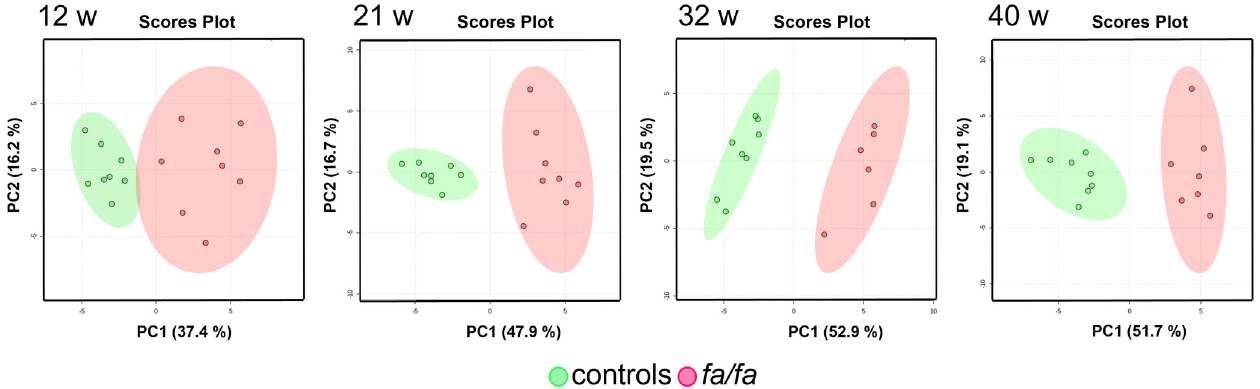
Figure 2. Score plots of PCA models of urine at 12, 21, 32, and 40 weeks. Fa / fa group is marked in red, control group in green .